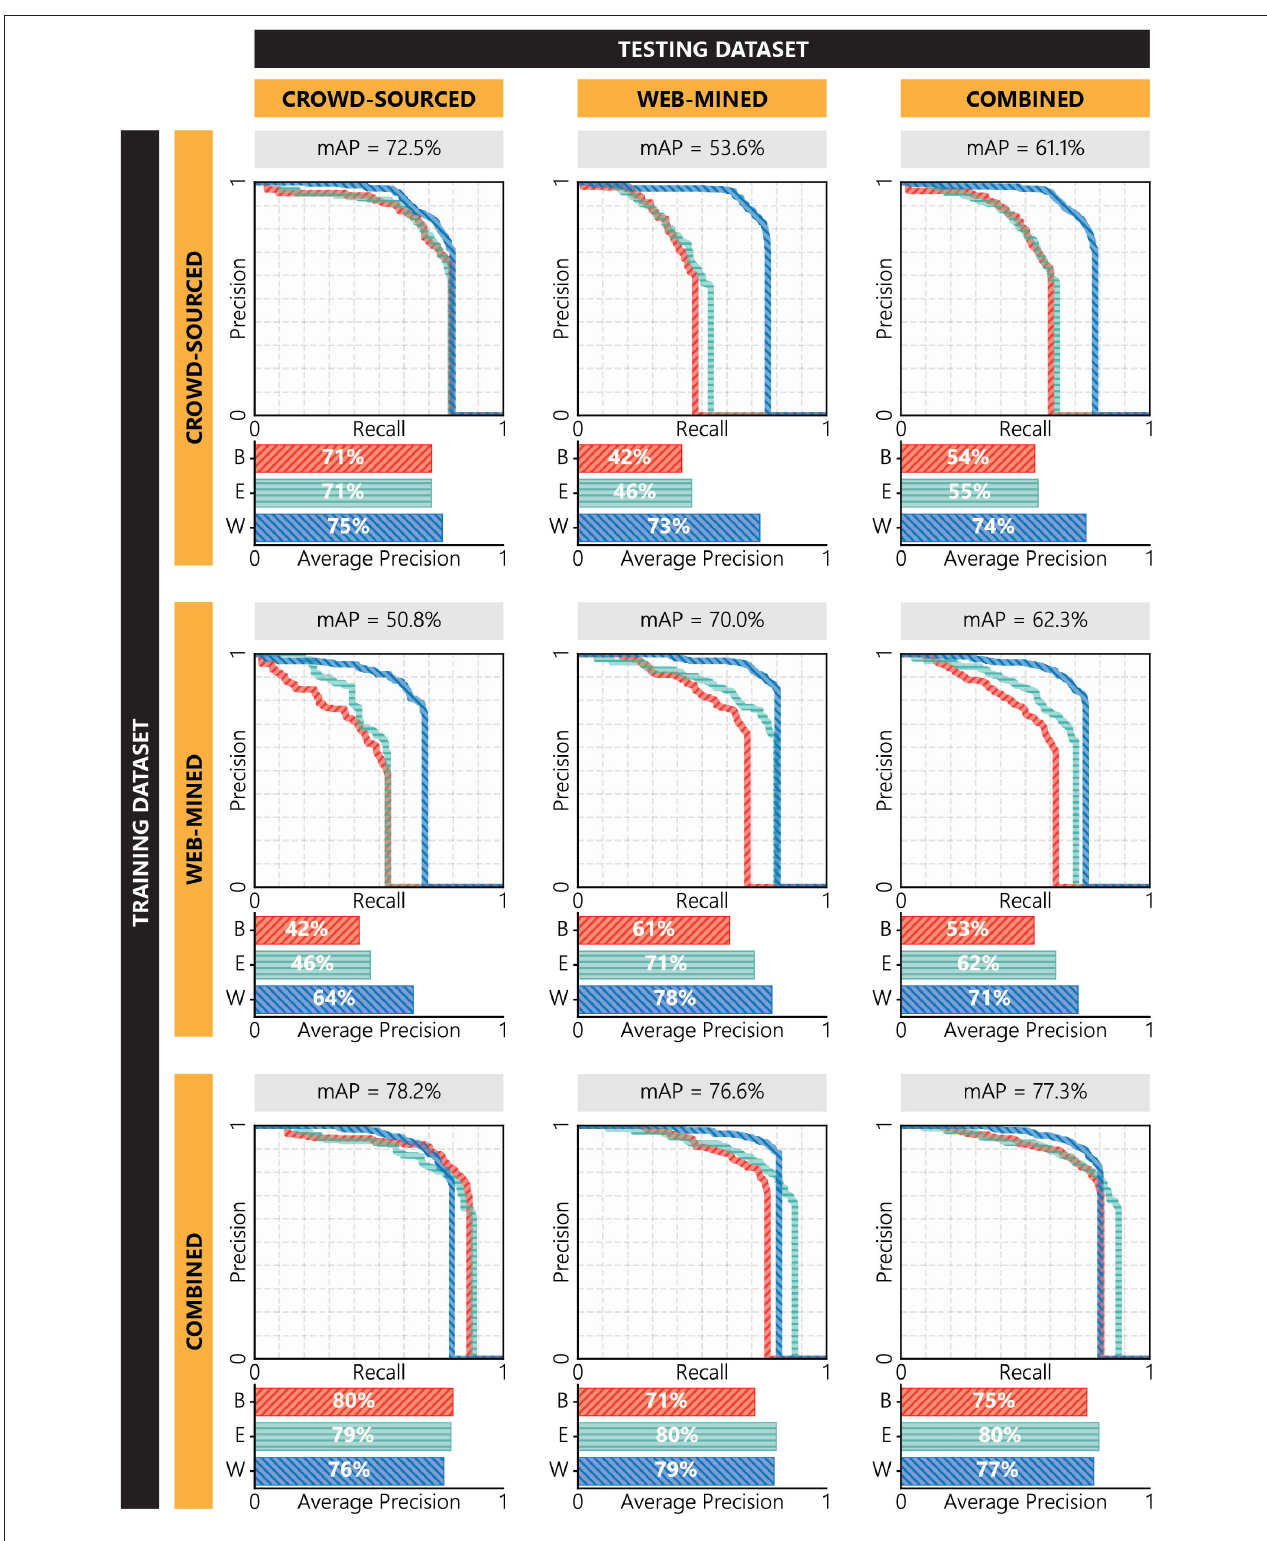
FIGURE 10 | Performance of YOLO-v3 models trained and tested on different combinations of the Pictor-v2 dataset.